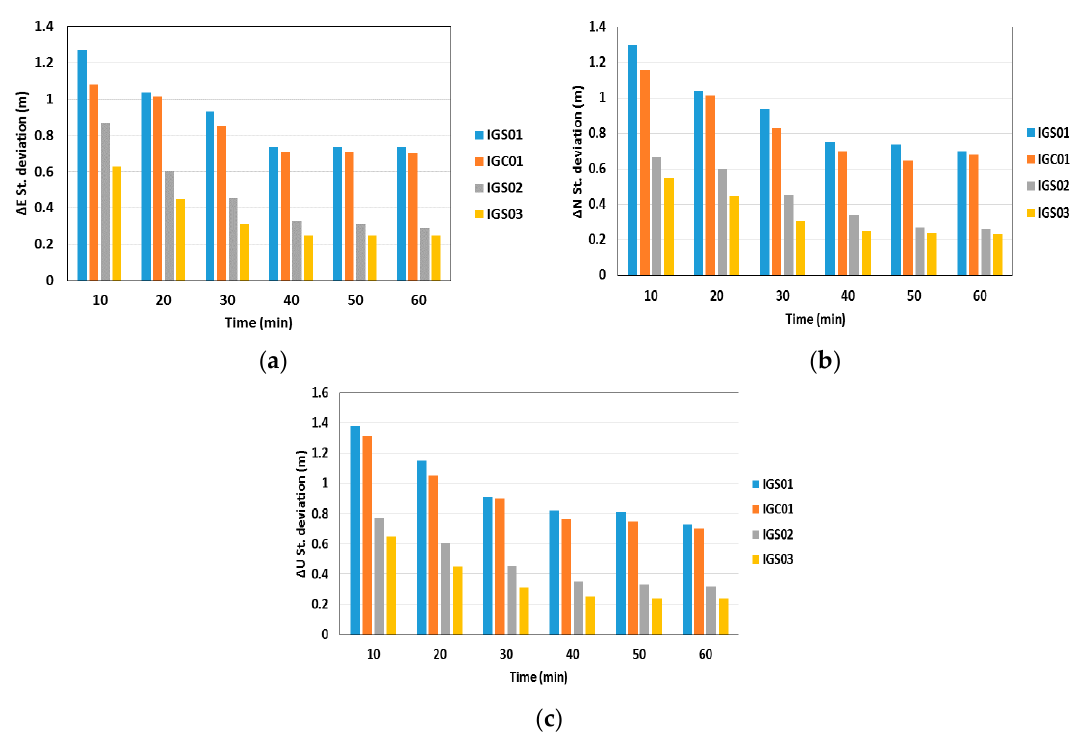
Figure 9. Summary of the RT-PPP positioning standard deviations in East, North, and Up directions. ( a ) East standard deviation; ( b ) North standard deviation; ( c ) Up standard deviation.